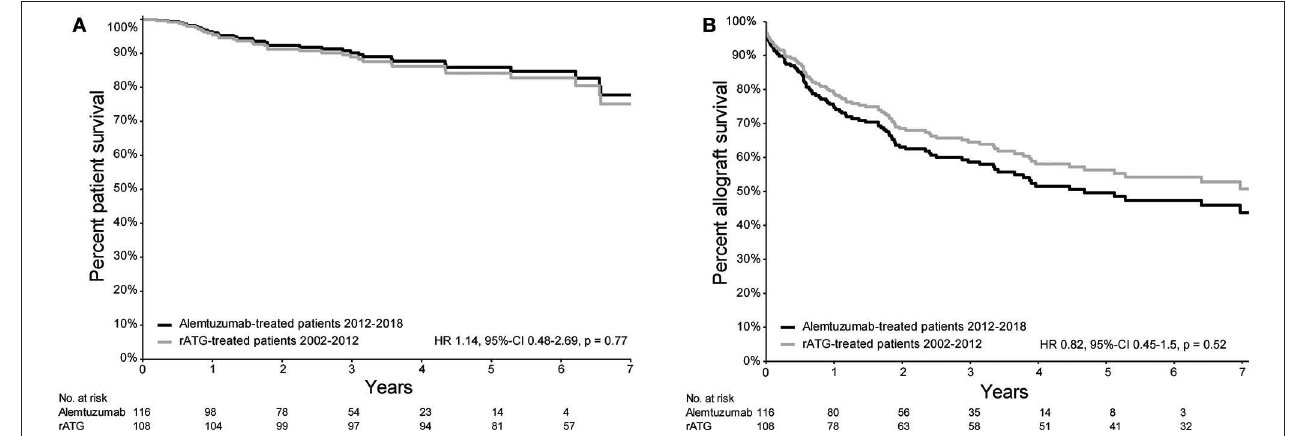
FIGURE 1 | Survival plots of patient- and allograft survival of patients with acute rejection and treated with either rATG or alemtuzumab. (A) Patient survival curve (from the time of treatment) based on the propensity score Cox regression model of patients treated with either alemtuzumab (2012–2018) or rATG (2002–2012) for acute kidney allograft rejection. (B) Allograft survival curve (from the time of treatment) based on the propensity score Cox regression model (event = allograft loss, censored for death) of patients treated with either alemtuzumab (2012–2018) or rATG (2002–2012) for acute kidney allograft rejection.